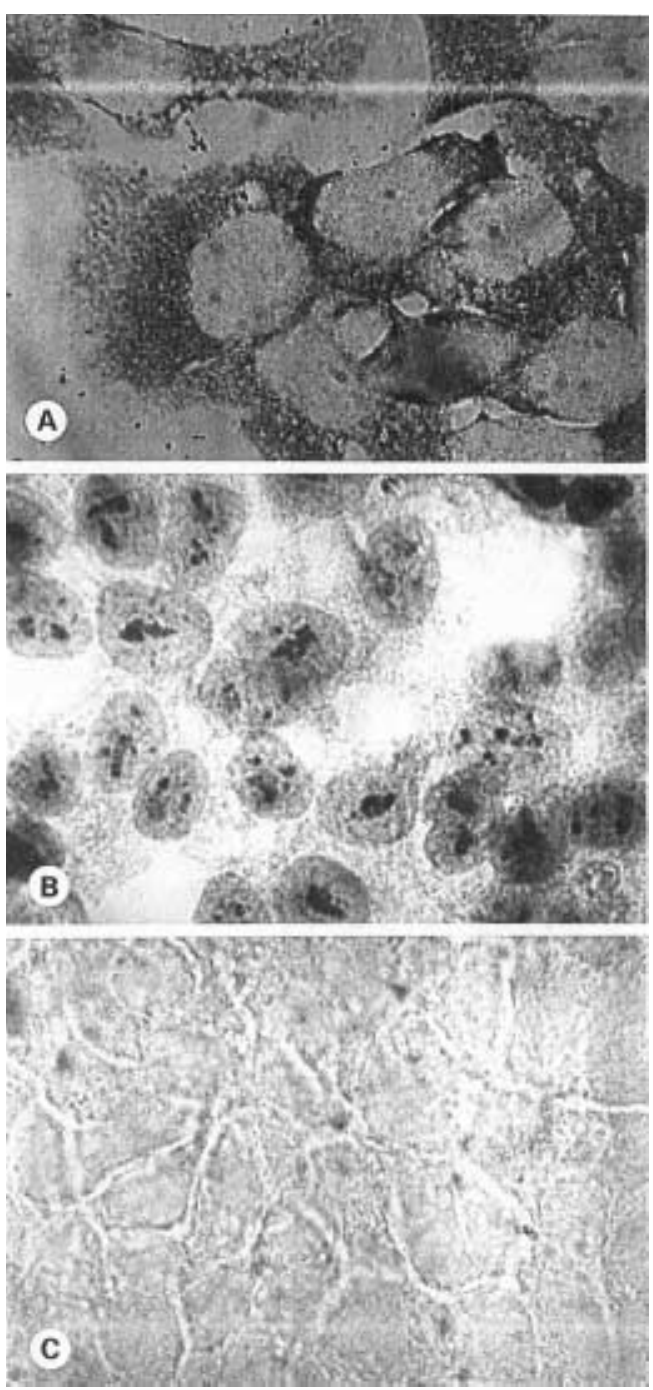
Fig. 3. Identification of sPLA 2 -mRNA in human HepG2 cells by in situ RT-nested PCR before (A) and after (C) pretreatment of cells with RNAse. In comparison, Mayer’s hematoxylin counterstaining was used (B). Original magnification ×